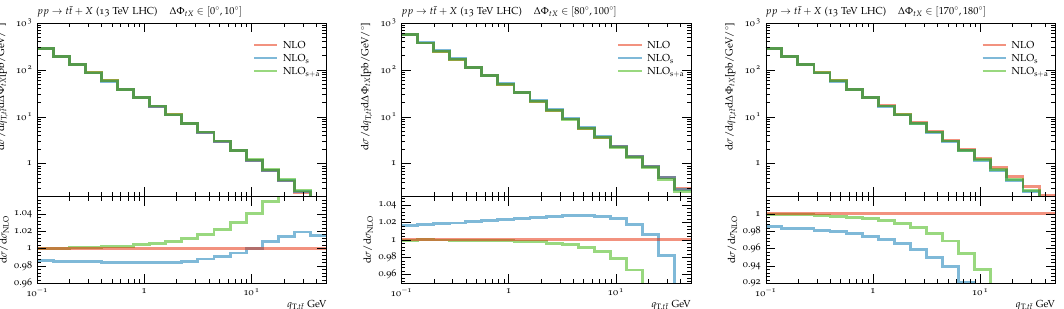
Figure 11 . Comparison of the NLO double differential spectra d σ tions of q T in slices of ∆Φ tX . Herein, NLO represents the QCD result calculated in S HERPA [169–171]. NLO s labels the azimuthally symmetric and NLO s+a marks the full, i.e. azimuthally symmetric and asymmetric , contributions derived from SCET II + HQET,